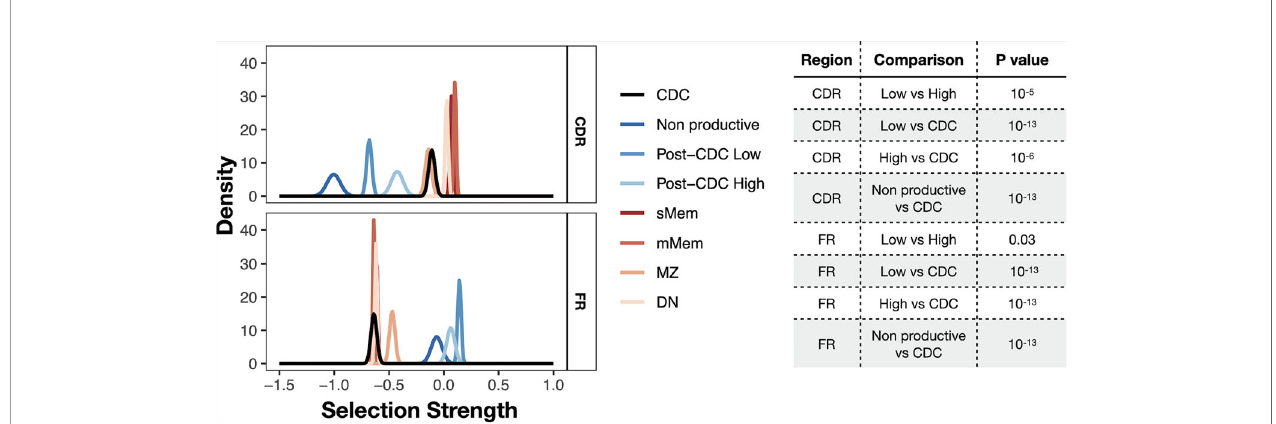
FIGURE 6 | Selection strength on mutations in VH CDRs and the VH FWRs. The BASELINe program was used to calculate Selection Strength ( S ; see Methods ) starting from observed and expected replacement to silent mutation ratios (R:S). Selection strength of mutations found in CDC and post-CDC productive and non- productive rearrangements based on complexity (post-CDC High and post-CDC Low ) as well as those of a series of normal human mature B cell subsets (IgM memory cells, mMem; isotype-class switched memory cells, sMem; marginal zone B cells (MZ); and IgD - CD27 − double negative B cells (DN). S indicates selection strength favoring selection for (right of 0) or against (left of 0) replacement mutations. Table to the right indicates the statistical analyses for selected differences between comparisons in the VH CDRs and VH FRs involving mutations detected in CDC and post-CDC productive and non-productive sequences divided based on post- IGHV-IGHD-IGHJ diversity into High and Low as described in Figure 1 . All comparisons were signi fi cantly different except for the following: for CDR: CDC vs . MZ; mMem vs . sMem; and sMem vs . DN; for FR: post-CDC High vs . post-CDC Low ; post-CDC High vs . non-Productive; CDC vs . mMem; CDC vs . sMem; CDC vs . DN; mMem vs . sMem; mMem vs . DN; sMem vs . DN. A complete list of statistical comparisons can be found in Supplemental Table S2 .